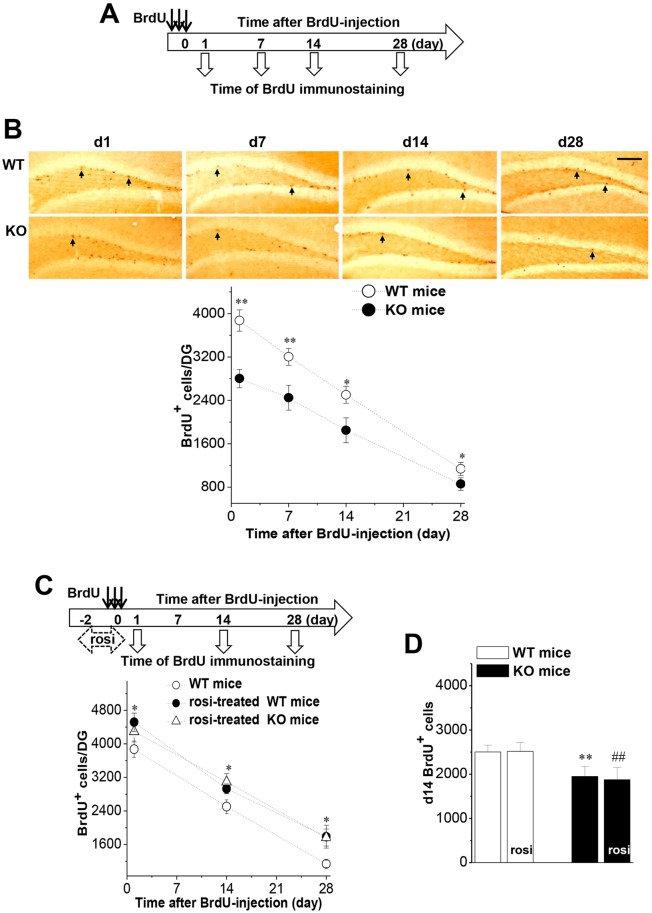
Seipin deficiency suppresses adult neurogenesis in the DG by reducing PPARγ. (A) Time chart of experimental procedure. Black arrows (↓) indicate the time of BrdU injection. Hollow arrows indicate the time of BrdU immunostaining. (B) Each point in the graph represents the group mean of BrdU+ cells at day 1 after the last BrdU injection (d1), d7, d14 and d28 in seipin-nKO mice and wild-type (WT) mice. Representative images of BrdU immunostaining in seipin-nKO mice (KO) and WT mice. Black arrows indicate BrdU+ cells. Scale bar: 200 μm. *P<0.05, **P<0.01 vs WT mice. (C) Influence of rosi treatment for 3 days before the last injection of BrdU on the number of d1, d14 or d28 BrdU+ cells in WT mice and seipin-nKO mice treated with rosi. *P<0.05 vs WT mice. (D) Effects of rosi treatment at d7-d12 after BrdU injection on the d14 BrdU+ cells in seipin-nKO mice and WT mice. **P<0.01 vs WT mice; ##P<0.01 vs seipin-nKO mice.